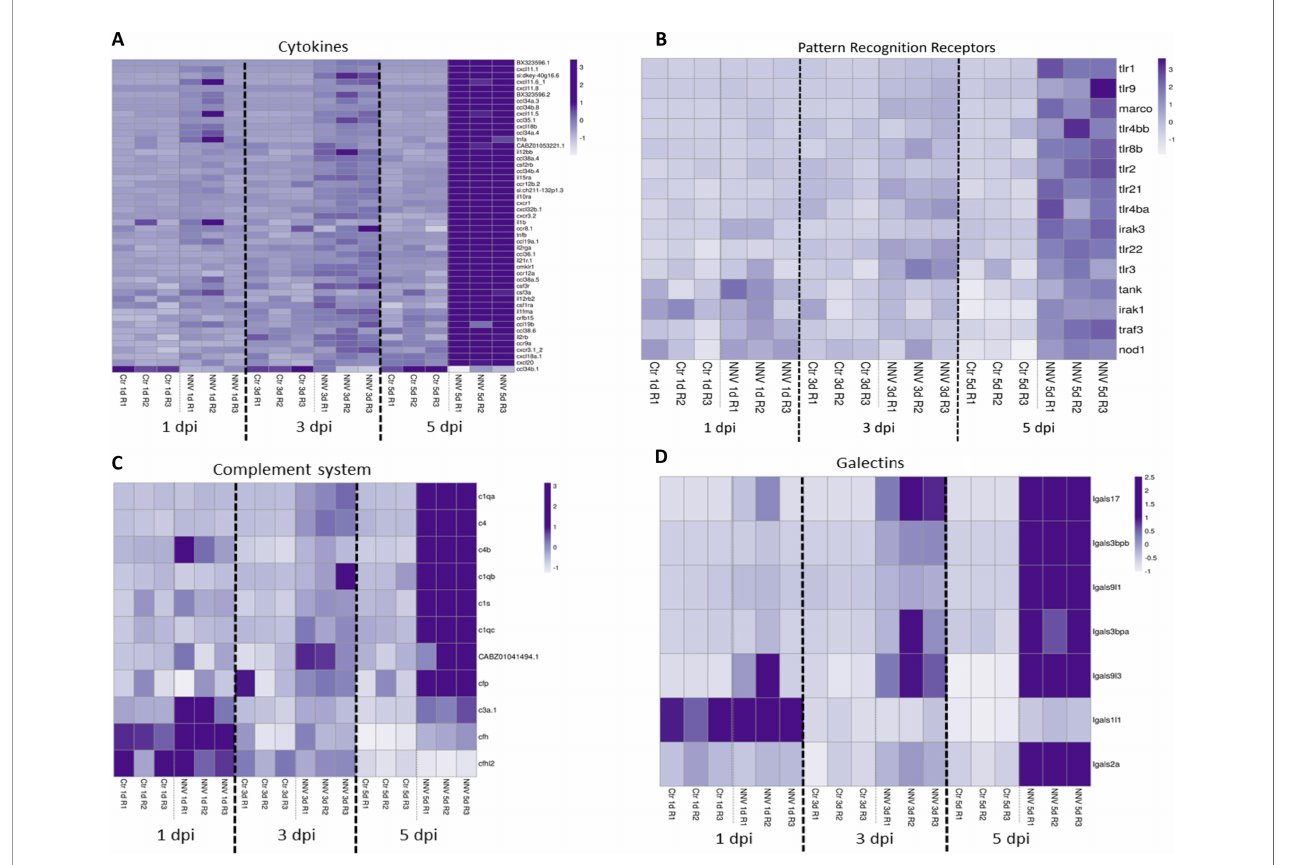
FIGURE 9 | Heatmaps representing the DEGs belonging to different immune categories at 1, 3 and 5 dpi: (A) cytokines; (B) pattern recognition receptors; (C) complement system; and (D) galectins. Heatmaps were constructed with the TPM expression values of the DEGs. Expression levels are represented as row- normalized values on a white – purple colour